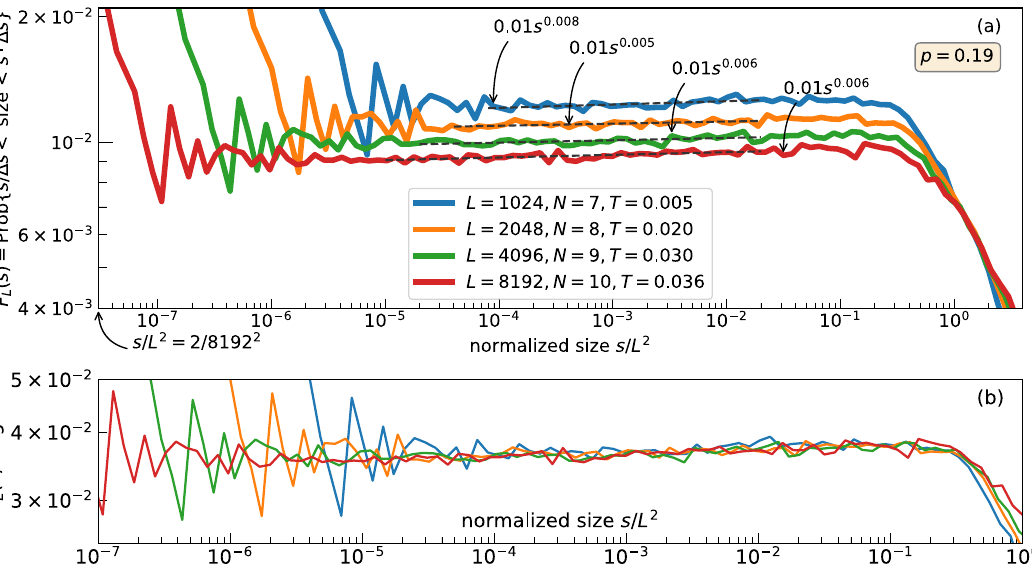
Figure 1. Segment of the size-frequency relation: main result. Power-law segment obtained with exponentially increasing horizontal bins, i. e., the power-law exponent is increased by 1. The vertical axis is not normalized in ( a ) but normalized in ( b